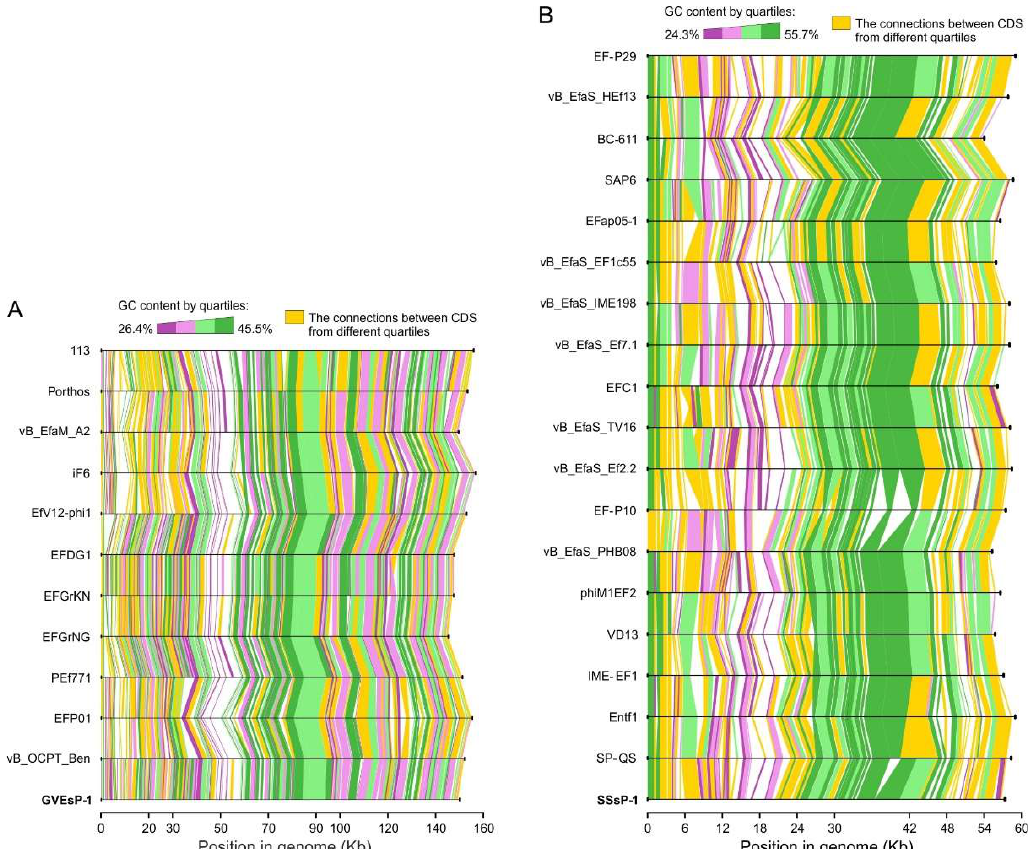
Figure 5. Protein-coding gene synteny in Schiekvirus ( A ) and Saphexavirus ( B ). The black axes correspond to the whole-genome sequences, whereas the colored connections indicate homologous coding sequences, determined by BLAST searches. All CDSs in the dataset were divided into quartiles according to their GC content. Color scale from purple to green indicates homology between the sequences within the same quartiles. The connections between CDSs from different quartiles are colored orange.